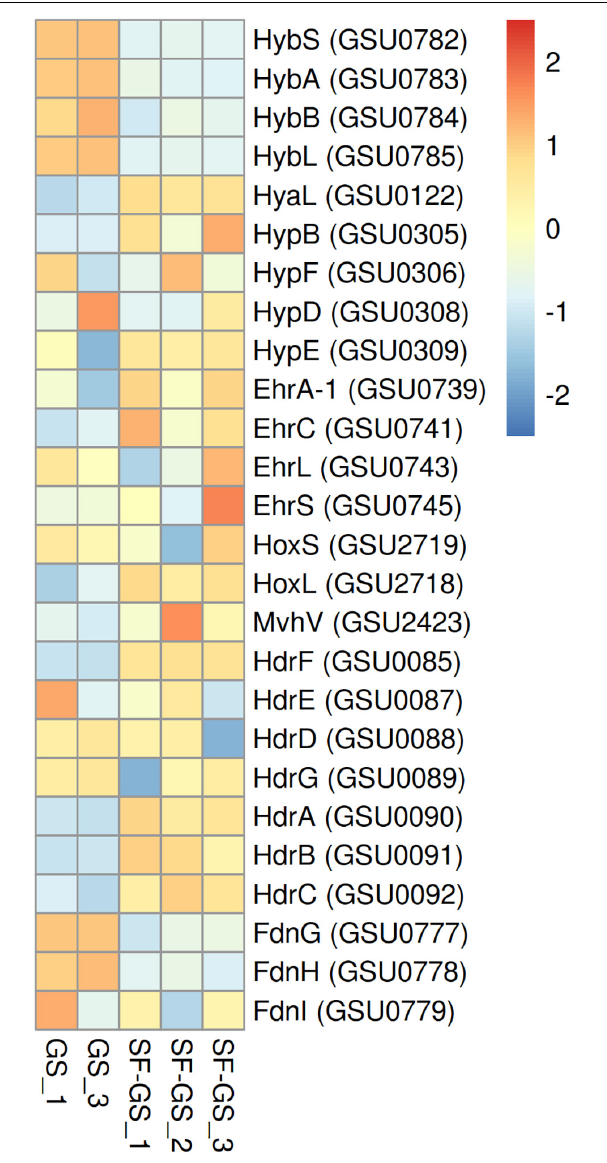
FIGURE 6 | Relative abundance of the detected hydrogenases of GS in the SF-GS coculture versus the GS pure culture. Protein abundance levels are shown after Z -score normalization. The color intensity indicates the degree of protein presence, where high relative abundance is indicated in red and low relative abundance is indicated in blue. The rows in the heat map show the detected proteins in the SF-GS coculture and the GS pure culture. The columns show the cultures in replicates. The abbreviations of the proteins are as follows: Hyb: periplasmically oriented, membrane-bound [NiFe]-hydrogenase, small subunit (HybS), periplasmically oriented, membrane-bound [NiFe]-hydrogenase, iron-sulfur cluster-binding subunit (HybA), periplasmically oriented, membrane-bound [NiFe]-hydrogenase, cytochrome b subunit (HybB), periplasmically oriented, membrane-bound [NiFe]-hydrogenase, large subunit (HybL). Hya: periplasmically oriented, membrane-bound [NiFe]-hydrogenase, large subunit (HyaL). Hyp: hydrogenase accessory protein (HypB), hydrogenase maturation protein (HypF), hydrogenase expression/formation protein (HypD), hydrogenase expression/formation protein (HypE). Ehr: Ech-hydrogenase-related (Continued)